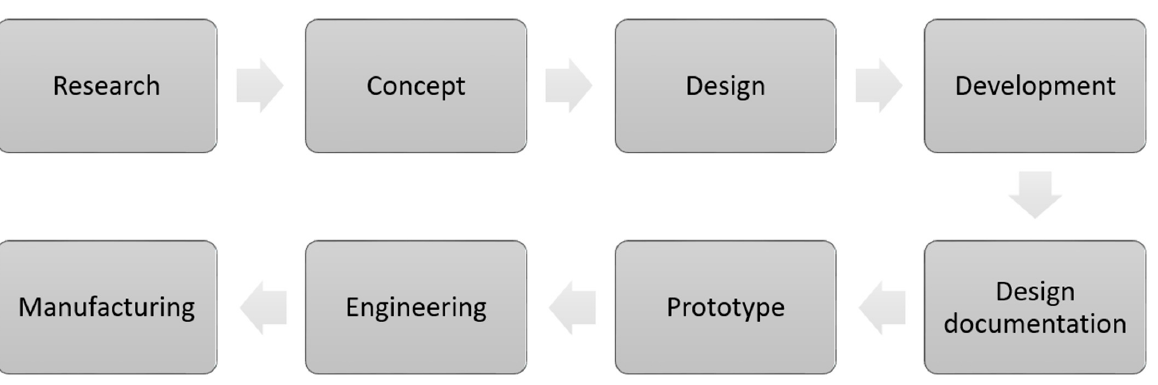
Figure 1. Design process flow.